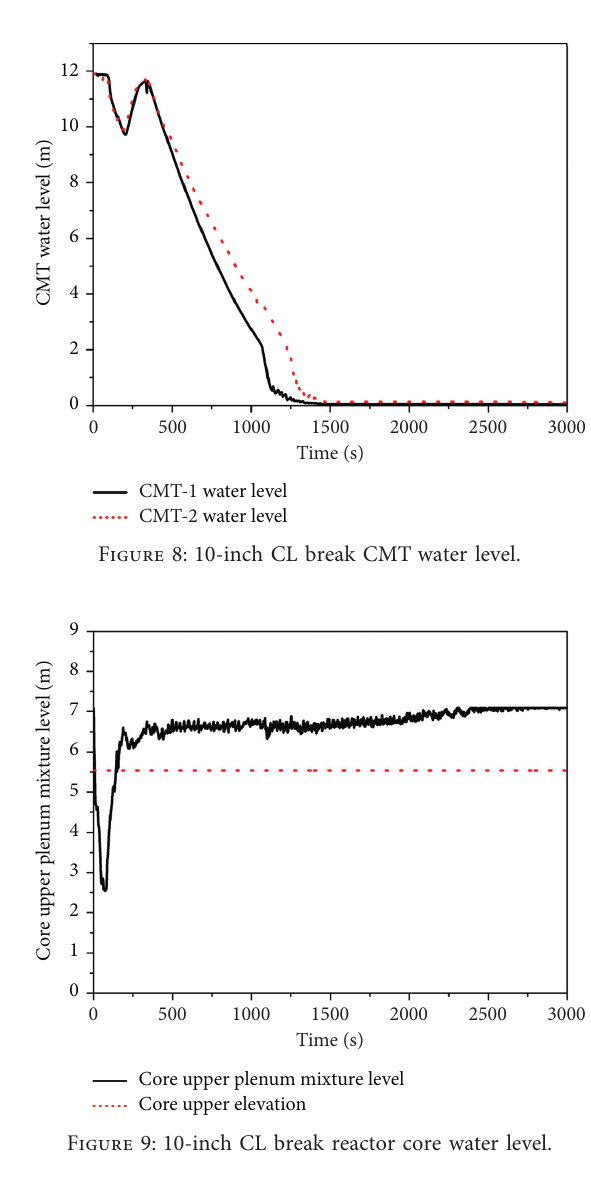
Figure 7: 10-inch CL break CMT injection mass flow rate.